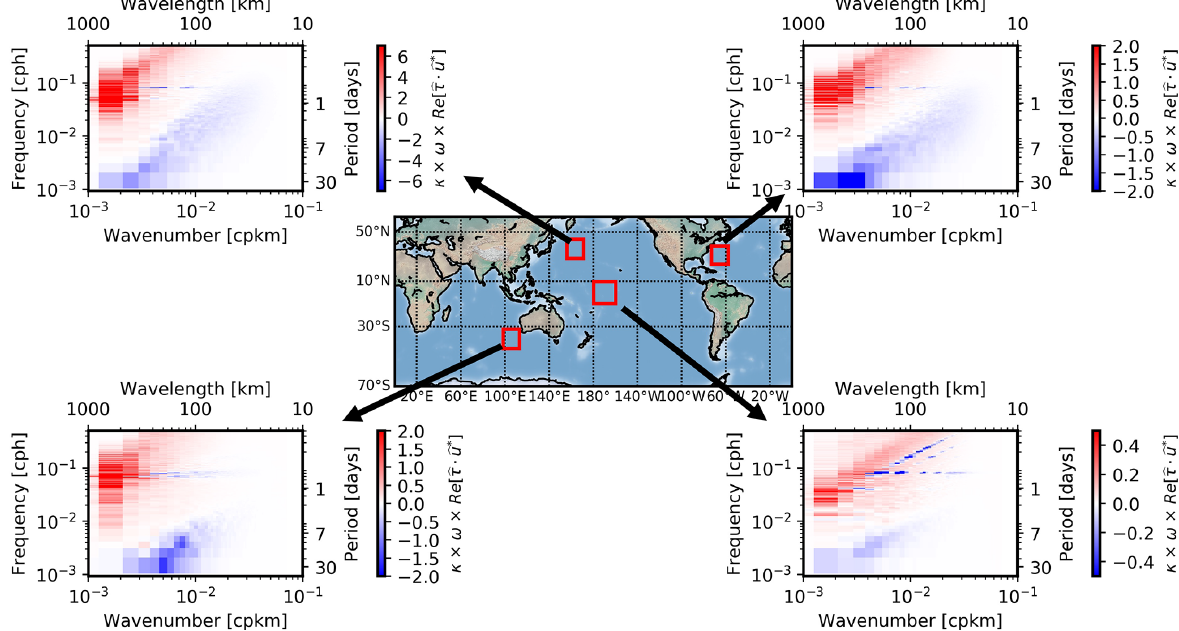
Figure 11. Co-spectrum of wind stresses and surface ocean currents in several regions from the COAS simulation (see square boxes in the middle panel). Note the color range is different in each